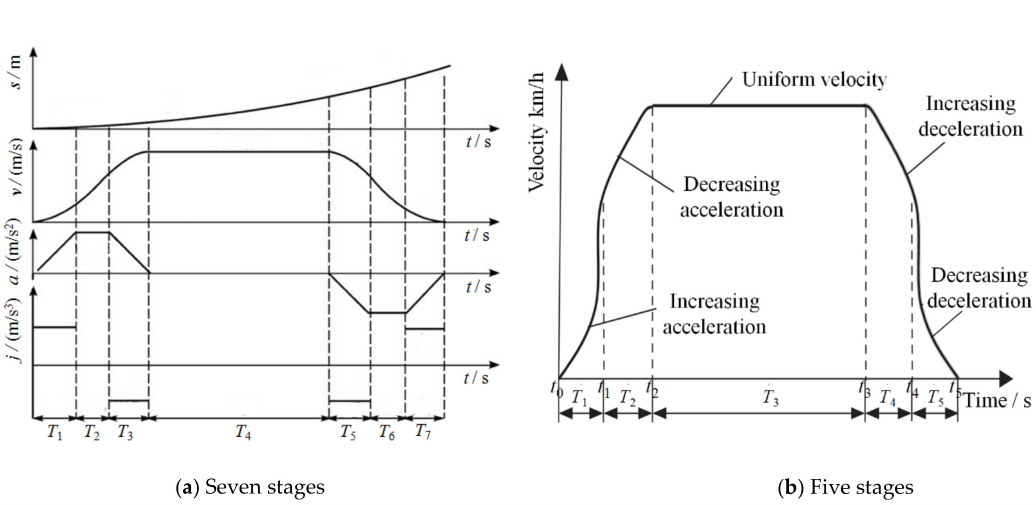
Figure 9. S-shaped velocity curve with acceleration and